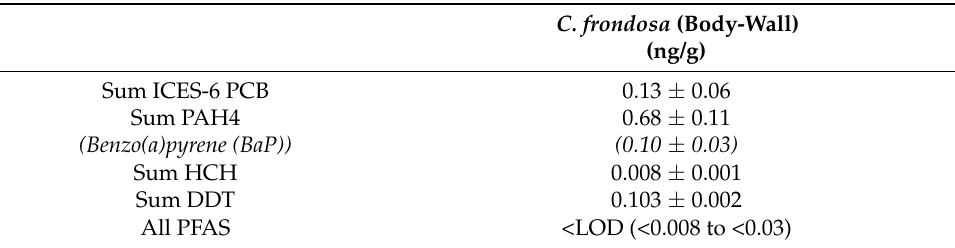
Table 6. Concentrations (ng/g) ICES-6 PCBs, Sum PAH4, benzo(a)pyrene, Sum HCHs, sum DDT, PAH and PFAS and various pesticides for wet weight orange-footed sea cucumber ( Cucumaria frondosa ) (average ± SD, n = 4). All values below or equal to level of detection (LOD) were set equal to